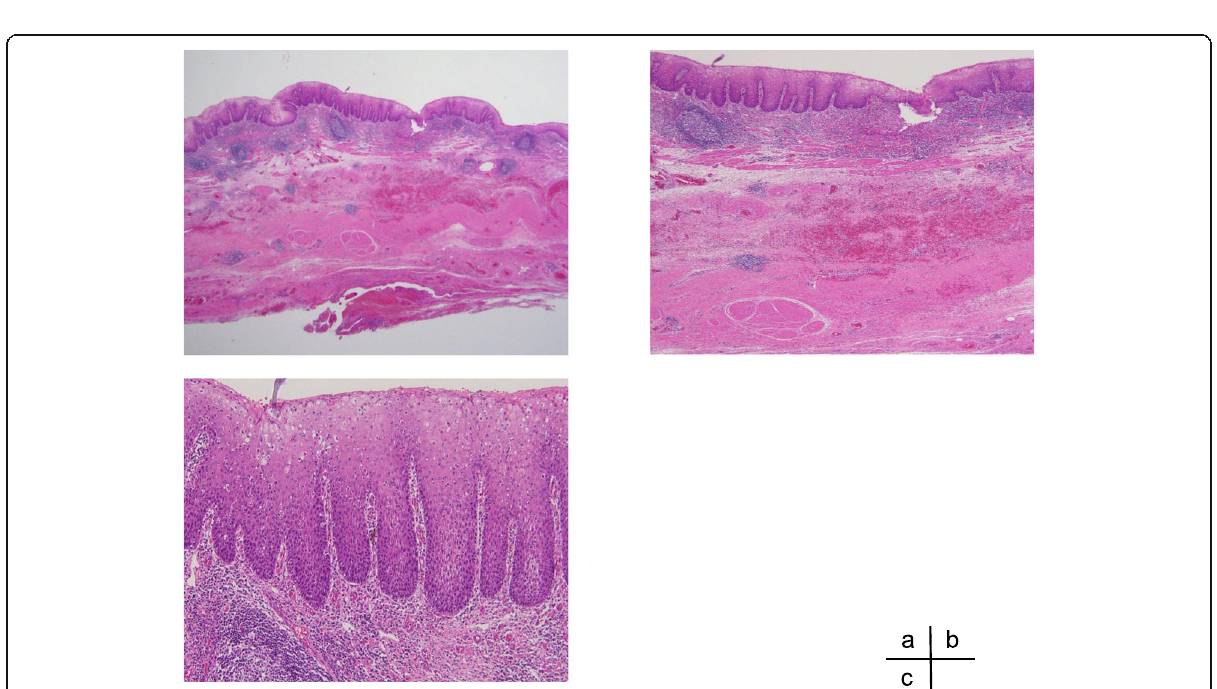
Fig. 5 a , b True diverticulum with a muscular layer and a highly inflamed mucosa. c No malignant findings were